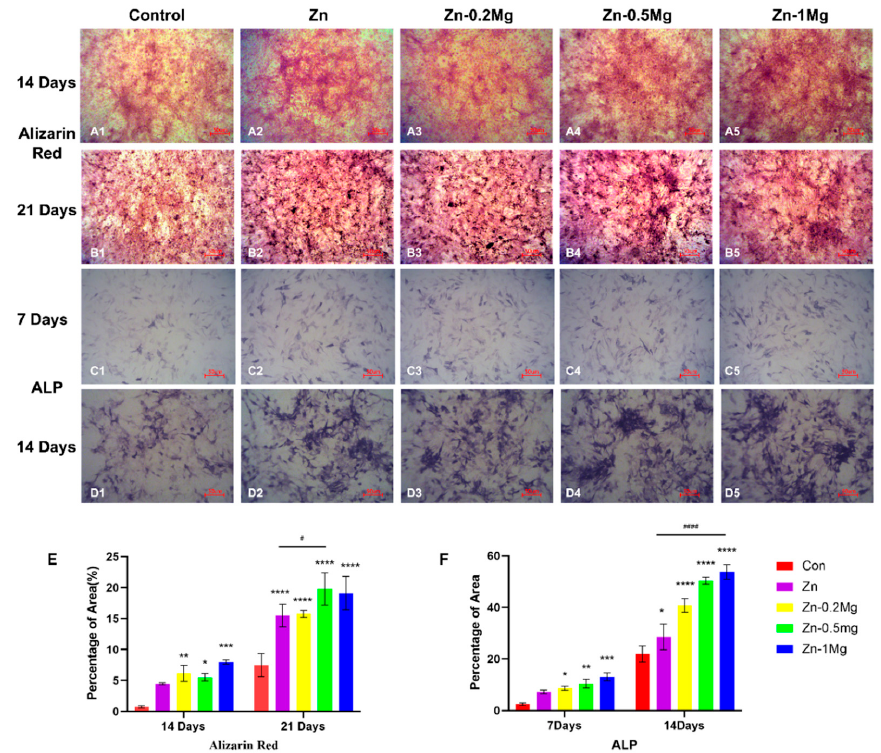
Figure 4. In vitro osteogenesis assessment ( A1 – A 5 were pictures of alizarin red for 14 days, B1 – B 5 were pictures of alizarin red for 21 days, and C1 – C 5 were pictures of ALP for 7 days). Plots of MC3T3-E1 cultured with various extracts for ( A , B ) alizarin red at 14 and 21 days, and ( C , D ) alkaline phosphatase (ALP) at 7 and 14 days ( E , F ) along with corresponding quantitative results. Compared with the control group, **** p < 0.0001, *** p < 0.001, ** p < 0.01, and * p < 0.05; compared with the Zn group, #### p < 0.0001, and # p < 0.05.